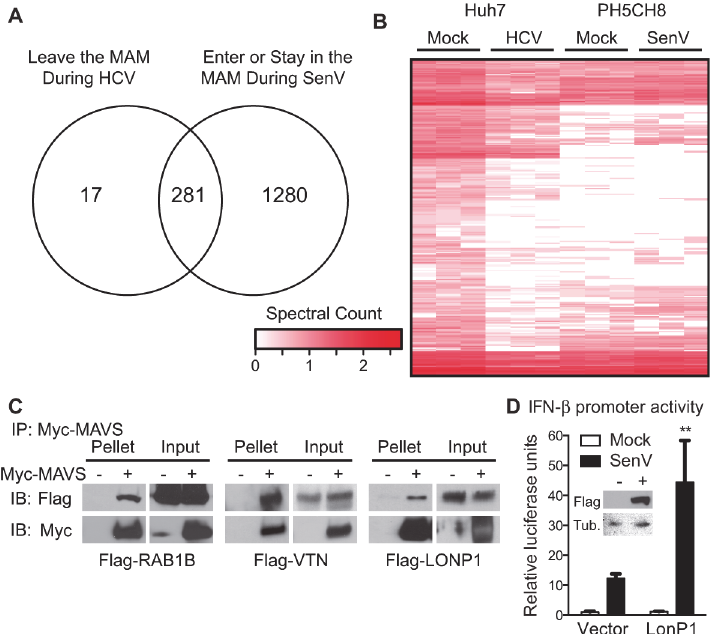
Fig 3. Identification of MAVS-interacting proteins using MAM proteomics. (A) Venn diagram of proteins that share a MAM-localization profile similar to that of MAVS. Proteins that move out of the MAM fraction during HCV (greater than 2-fold change over mock with a Benjamini-Hochberg corrected p-value of < 0.05) were compared to those that either move into the MAM or remain localized to the MAM during SenV infection. The 281 proteins in the intersection share this MAVS-localization pattern in the MAM during RNA virus infection. (B) Heat map of the 281 proteins with “ MAVS-like ” localization identified in MAM fractions from HCV and SenV, as well as mock (see panel A). Log 10 -transformed spectral counts across technical triplicates are represented by the color intensity shown in the key. (C) Immunoblot analysis of lysate (Input) and anti-Myc immunoprecipated extracts (Pellet) from cells expressing Myc-MAVS (+) or vector (-), and either Flag- RAB1B, Flag-VTN, or Flag-LONP1. (D) IFN- β promoter reporter luciferase expression of Huh7 cells expressing empty vector or Flag-LONP1 and then mock or SenV infected (24h). Values are mean -/+ SD (n = 3) of one of three replicate experiments; ** P < 0.01. (Inset) Immunoblot for Flag-LONP1 and tubulin (Tub.) protein